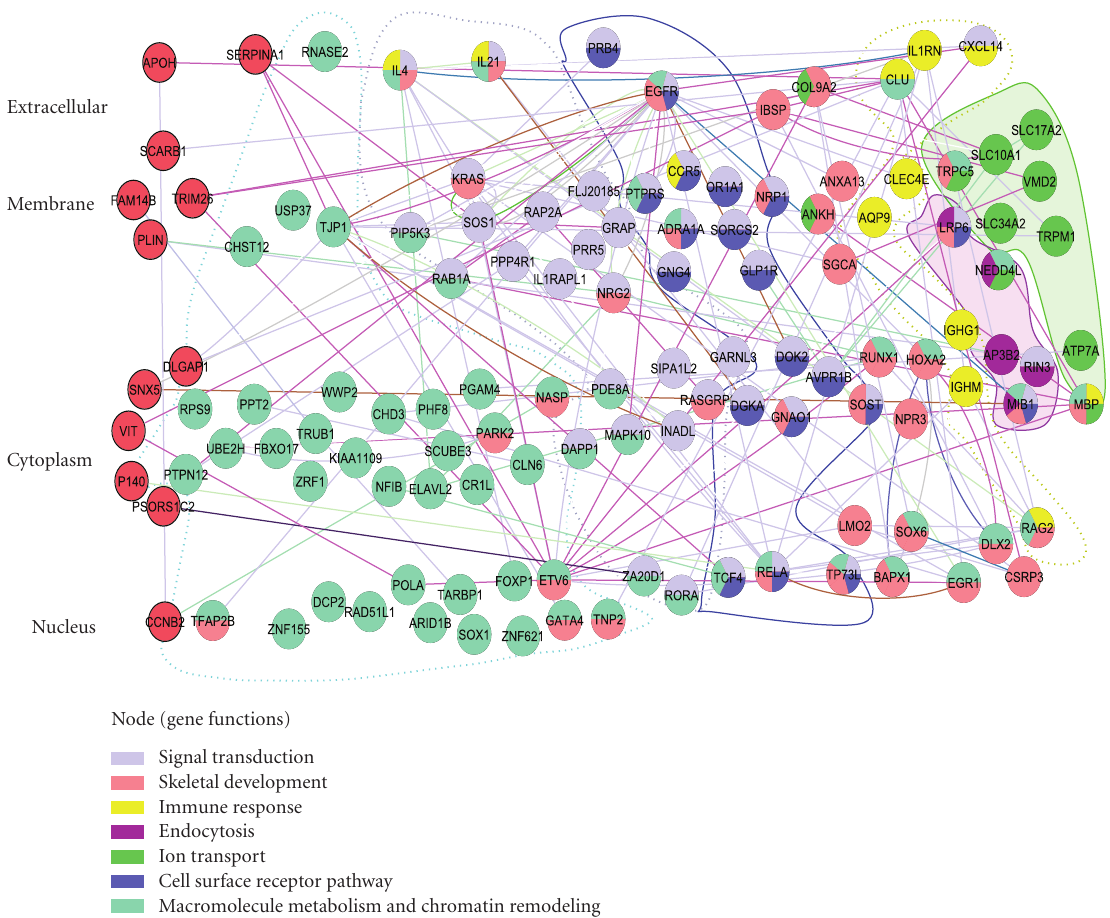
Figure 3: Network upregulated by HCMV entry. Genes shown here were upregulated by HCMV entry at both 5min and 25min PI. Genes are clustered into functional groups and color-coded. Only the primary functions for each gene are indicated. Nodes with red color on the left were not able to categorize into functional groups shown here. Cellular components are shown on the left